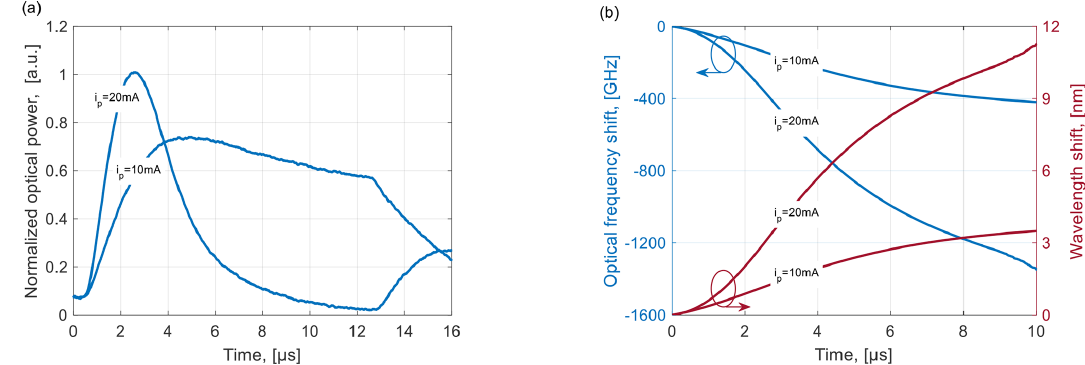
Figure 5. Optical waveforms (a) for VL-1577 captured by photodetector PD3 and corresponding (b) instantaneous optical frequency and wavelength shift achieved with a pump current of i B = 1, i P = 10 and i P = 20mA by the pulse width of 12µs and the repetition rate of